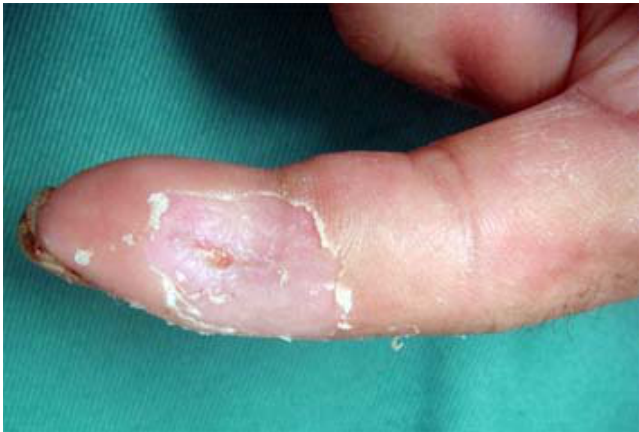
Figure 6. Two months after injury, the wound was completely healed. Case